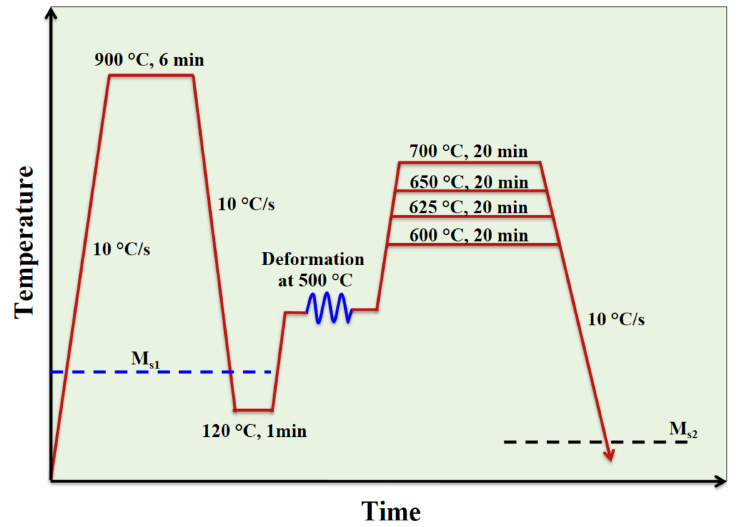
Figure 1. Sketch of the applied processing